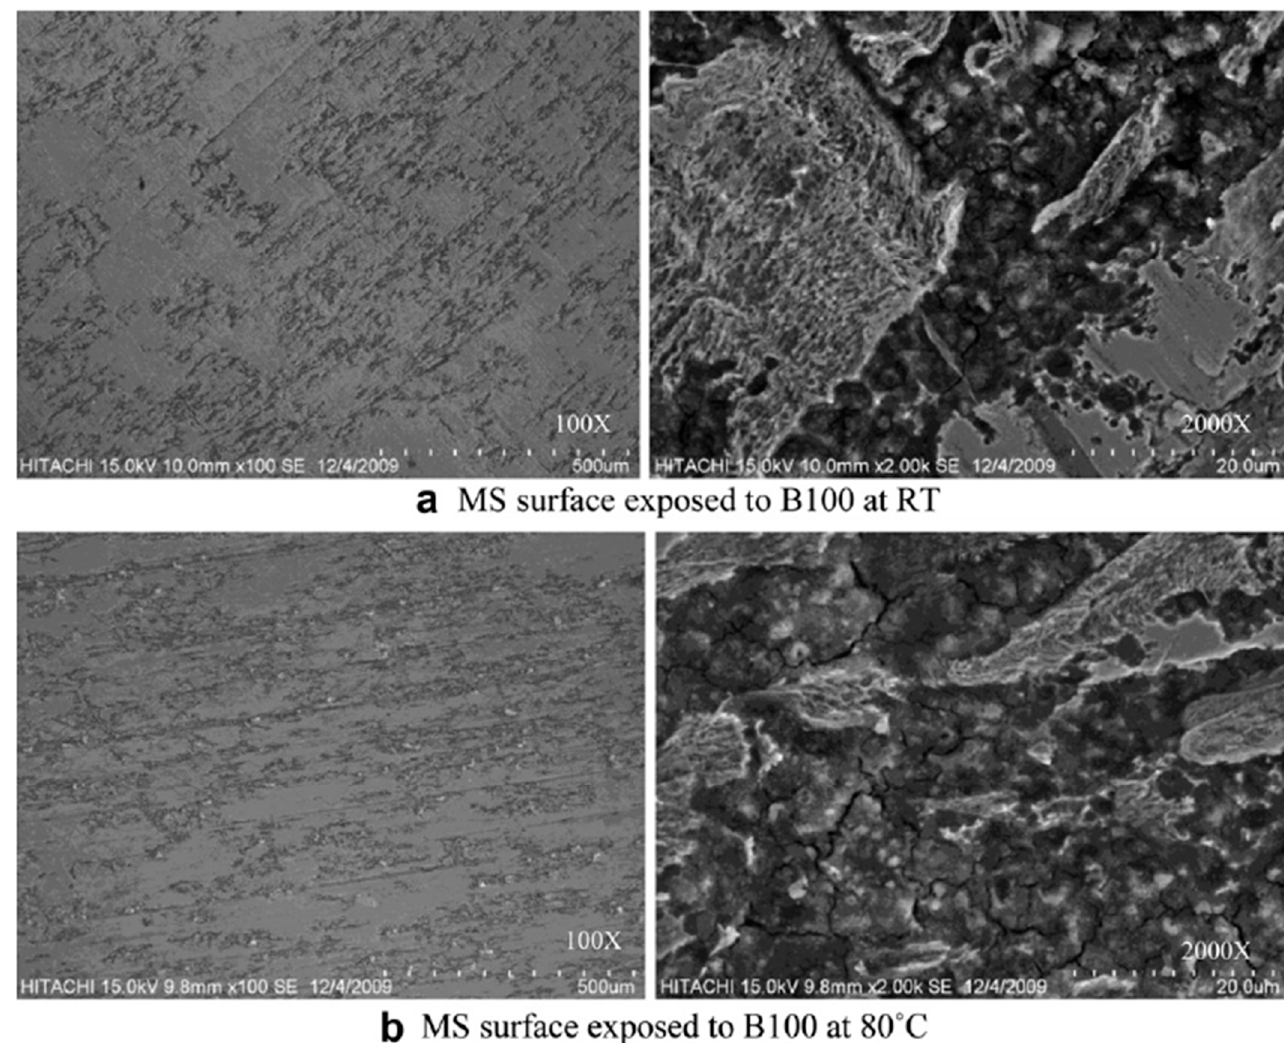
Figure 14. SEM images of as-received MS and on exposure to B0 (up) and B100 (down) at room temperature and 80 ◦ C [67].